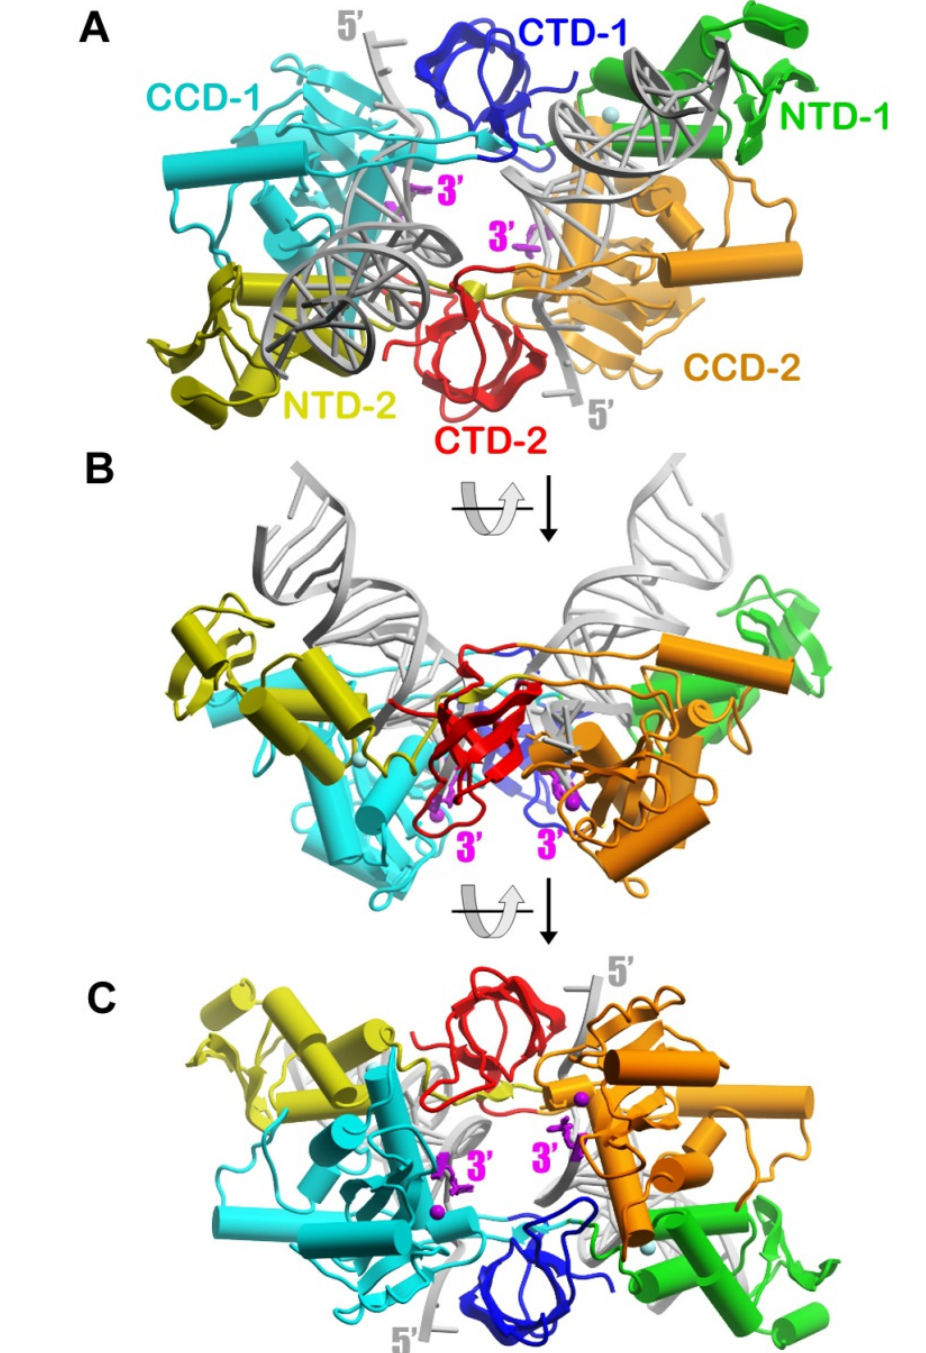
Figure 1. Schematic representation of the DNA-bound active subunits in the PFV intasome with the CCDs of outer monomers omitted for clarity (PDB ID: 3L2R [1]). (A) The NTD, CCD, and CTD of one monomer are shown in green, cyan, and blue, respectively. Analogous domains of the second monomer are colored as yellow, orange, and red. Helixes are shown as cylinders and strands as ribbons. The two DNA molecules are shown in grey. The reactive 3’ nucleotide is highlighted in magenta. The purple sphere is Mg 2+ . Orientations of the assembly in (B) represent a 90 degree rotation around the horizontal axis of the orientation in A). Correspondingly, the orientation in (C) is a 90 degree rotation from B). The picture was created with a ICM browser